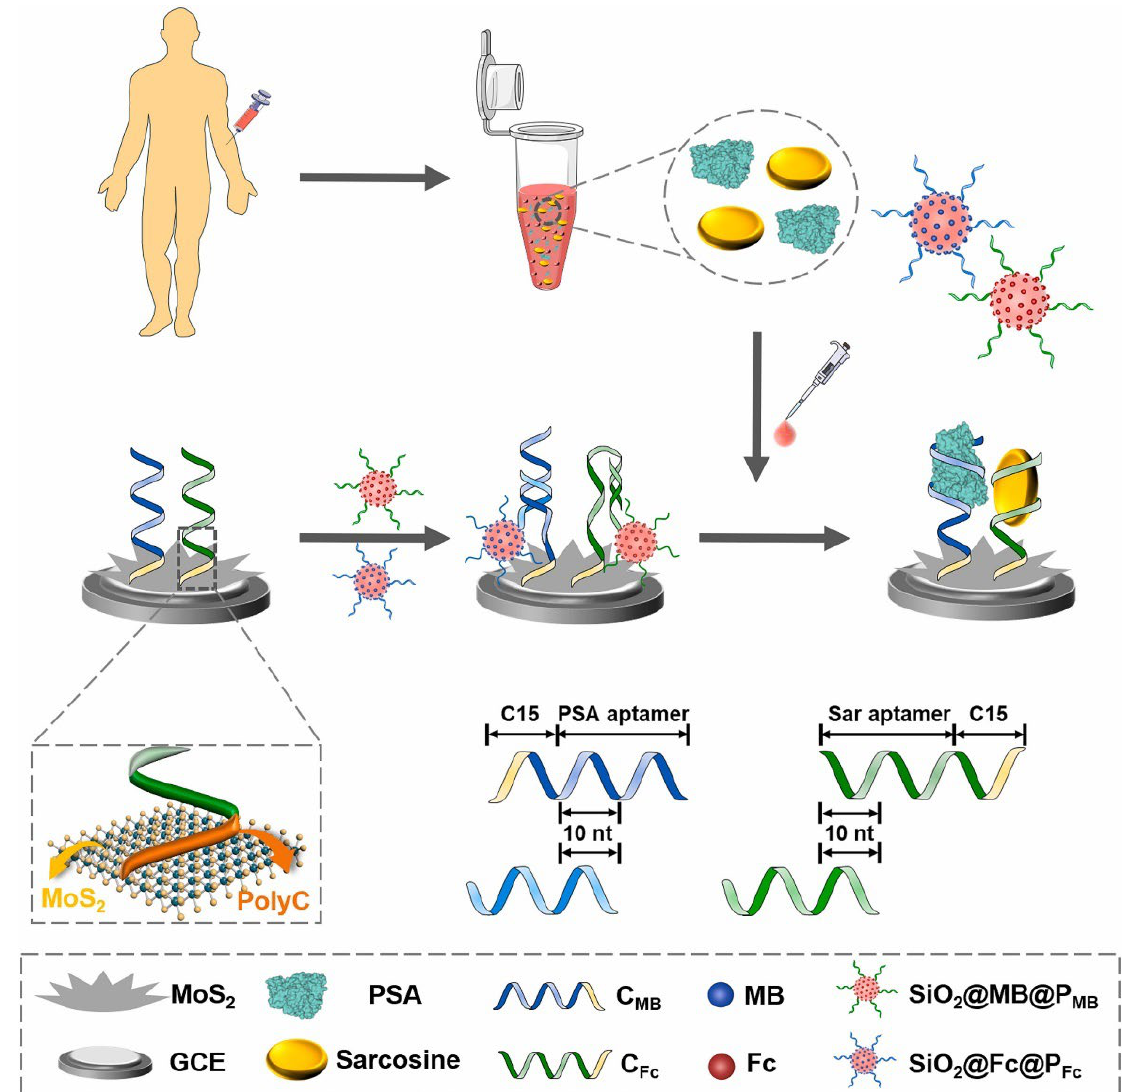
Figure 2. ( a ) Synthesis of tin disulfide NSs on CC, ( b ) flexibility of CC substrate, ( c ) stepwise fabri- cation of the proposed aptasensor and its electrochemical response. Reproduced with permission from [87].